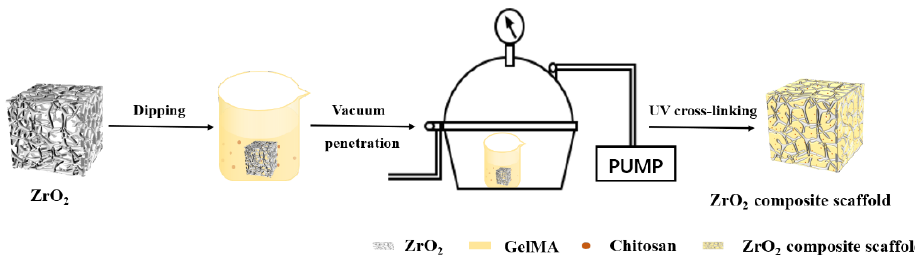
Figure 1. Schematic flowchart of the preparation of the ZrO2 – chitosan particles – GelMA composite